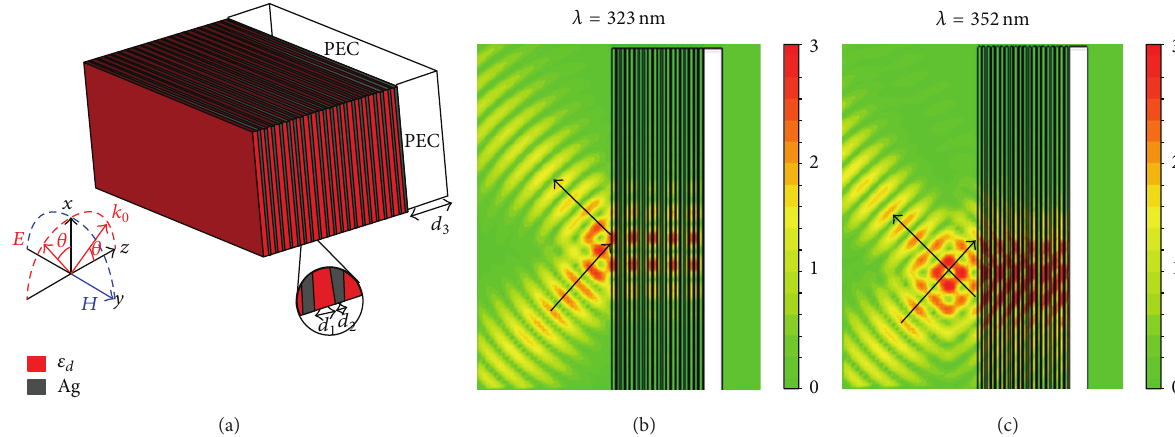
Figure 7: (a) Geometry of a hyperbolic metamaterial terminated by a PEC (mirror) slab with thickness 𝑑 3 = 300 nm. Tunable (b) positive and (c) negative Goos-H¨anchen shifts obtained at two different illumination wavelengths: 𝜆 = 323 nm and 𝜆 = 352 nm,